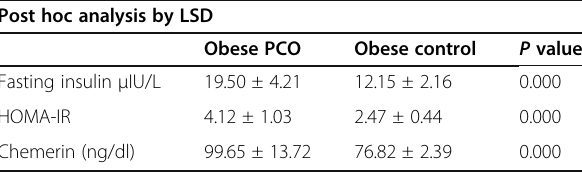
Table 6 Post hoc analysis (lean PCO and obese control) as regards fasting insulin, HOMA-IR, and chemerin Post hoc analysis by